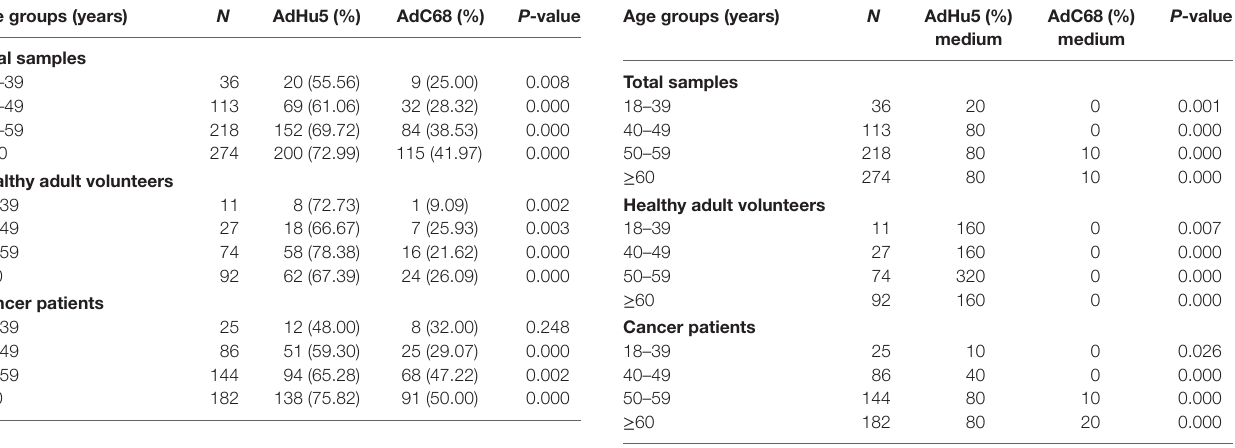
Table 7 | Seroprevalence of AdHu5 and AdC68 neutralizing antibody in different age groups. age groups